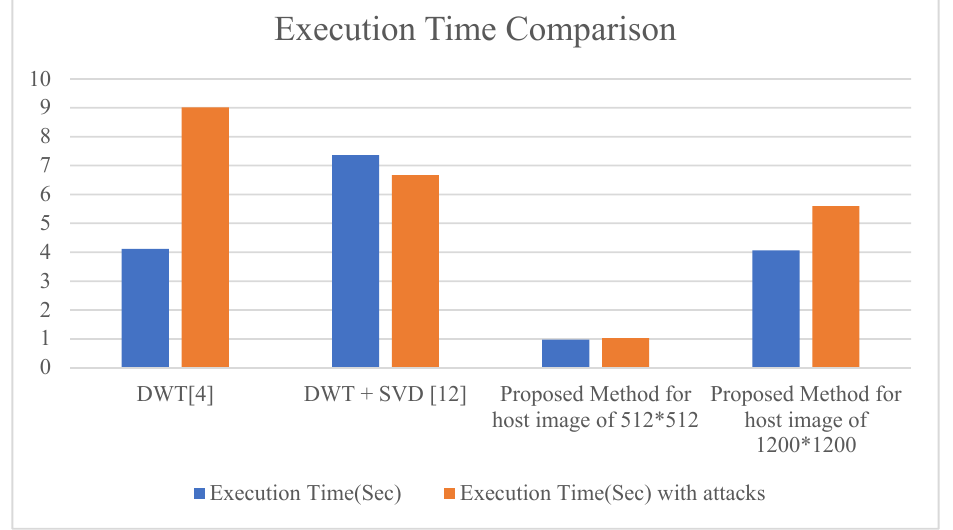
Figure 18. Execution time comparison. Table 7. Results comparison of PSNR and MSE.